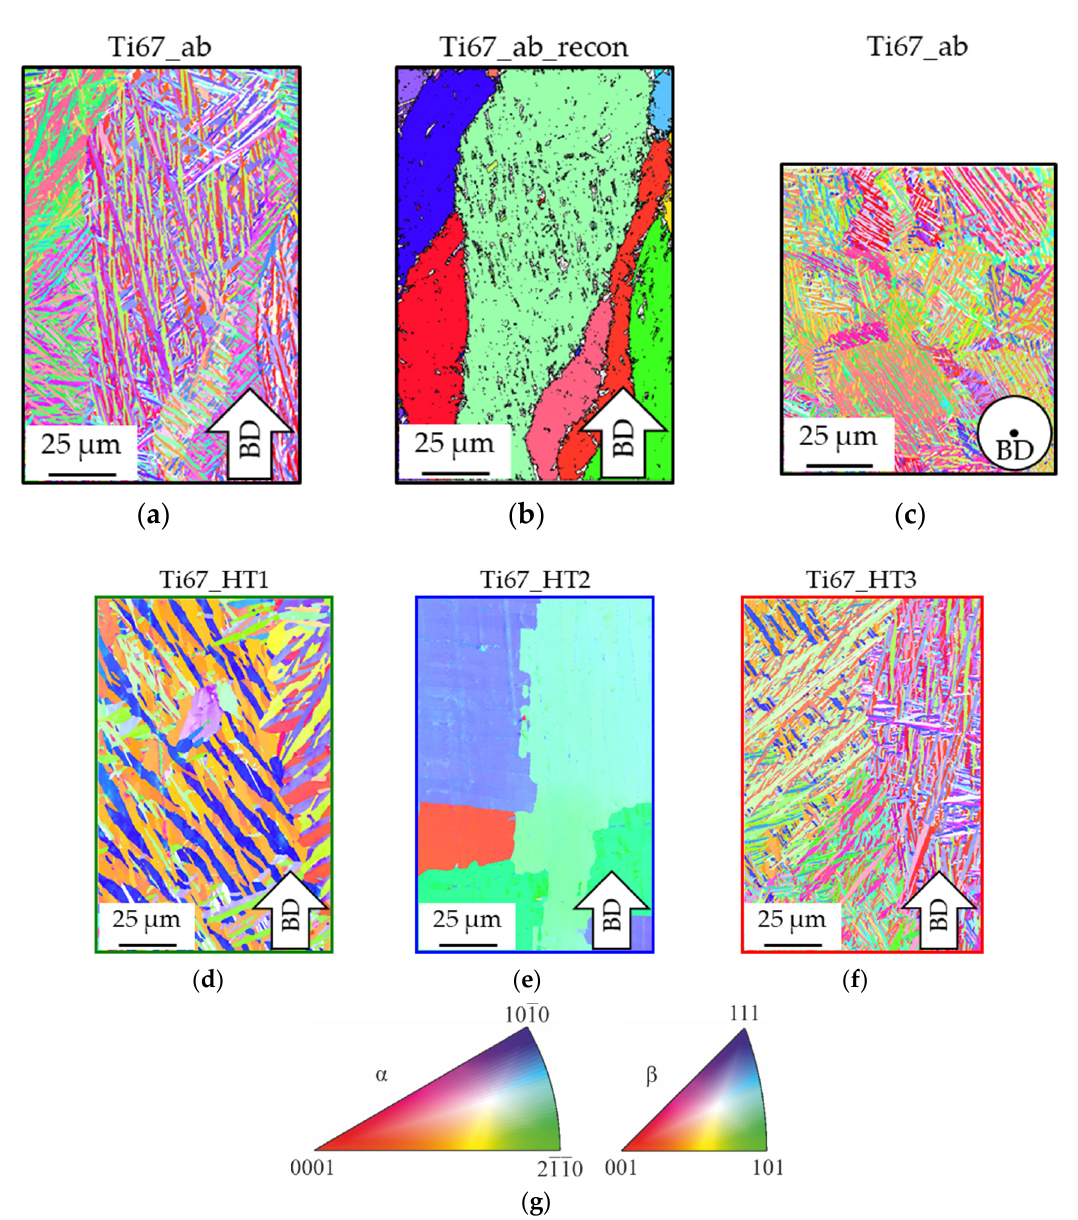
Figure 3. ( a ) Inverse pole figure (IPF) of as-built Ti-6Al-7Nb; ( b ) β parent grain reconstruction of ( a ); IPF of as-built (top view) ( c ); HT1 ( d ); HT2 ( e ); and HT3 ( f ) Ti-6Al-7Nb; and ( g ) color legend for inverse pole figure.